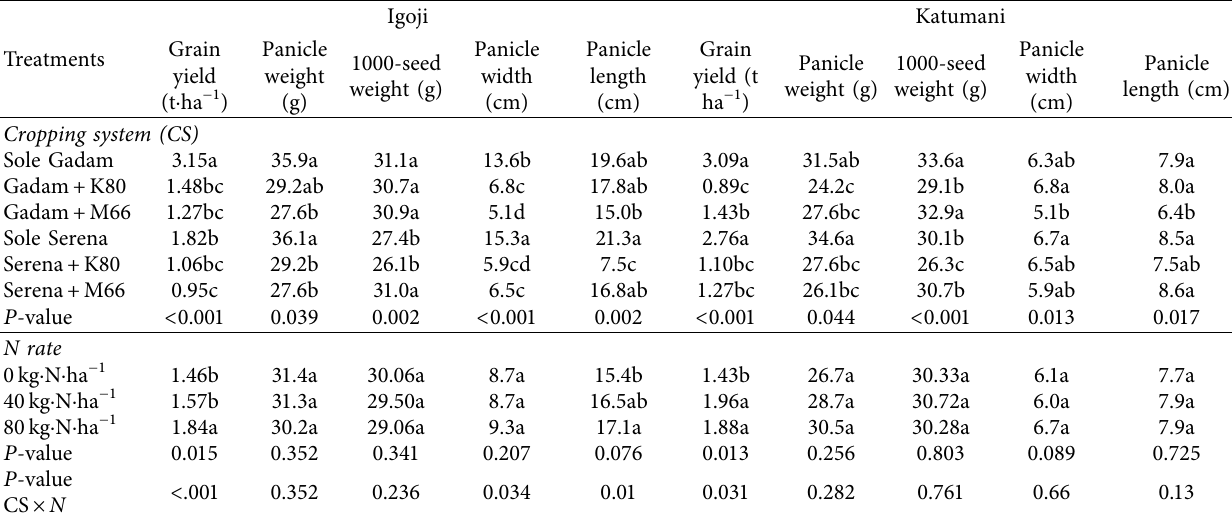
Table 2: Sorghum grain yield, panicle weight, 1000-seed weight, panicle width, and length of two sorghum varieties (Gadam and Serena) grown in sole and intercrop system with two varieties of cowpea (K80 and M66) and at three N rates at the KALRO research stations in Igoji and Katumani during 2018/2019 short rains season.